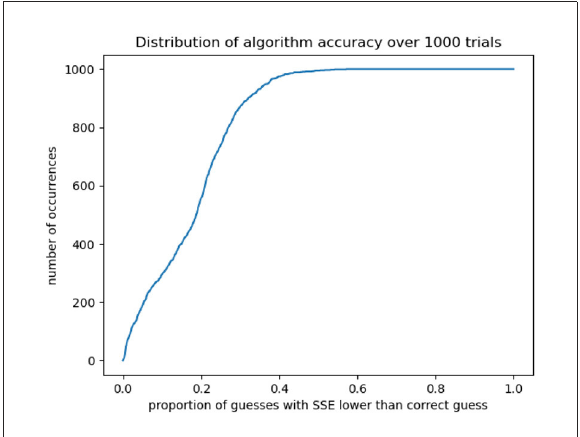
FIGURE4 For 1,000 synthetically generated test cases, we calculate whether the correct exponent-pair occurs within the lowest-SSE “x” percent of the space. In most cases the algorithm can isolate roughly two-fifths of the original space which may then be explored in more detail for a closer-fitting